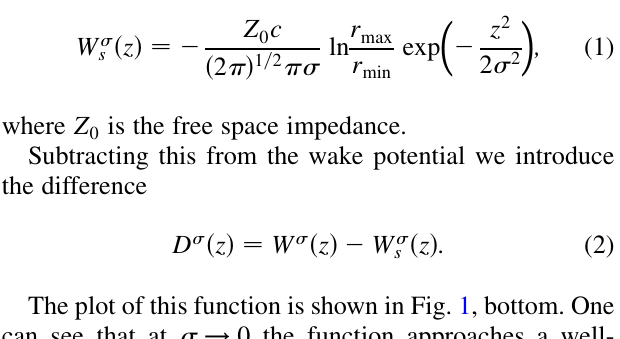
¼ 3 r ¼ 3 cm max min